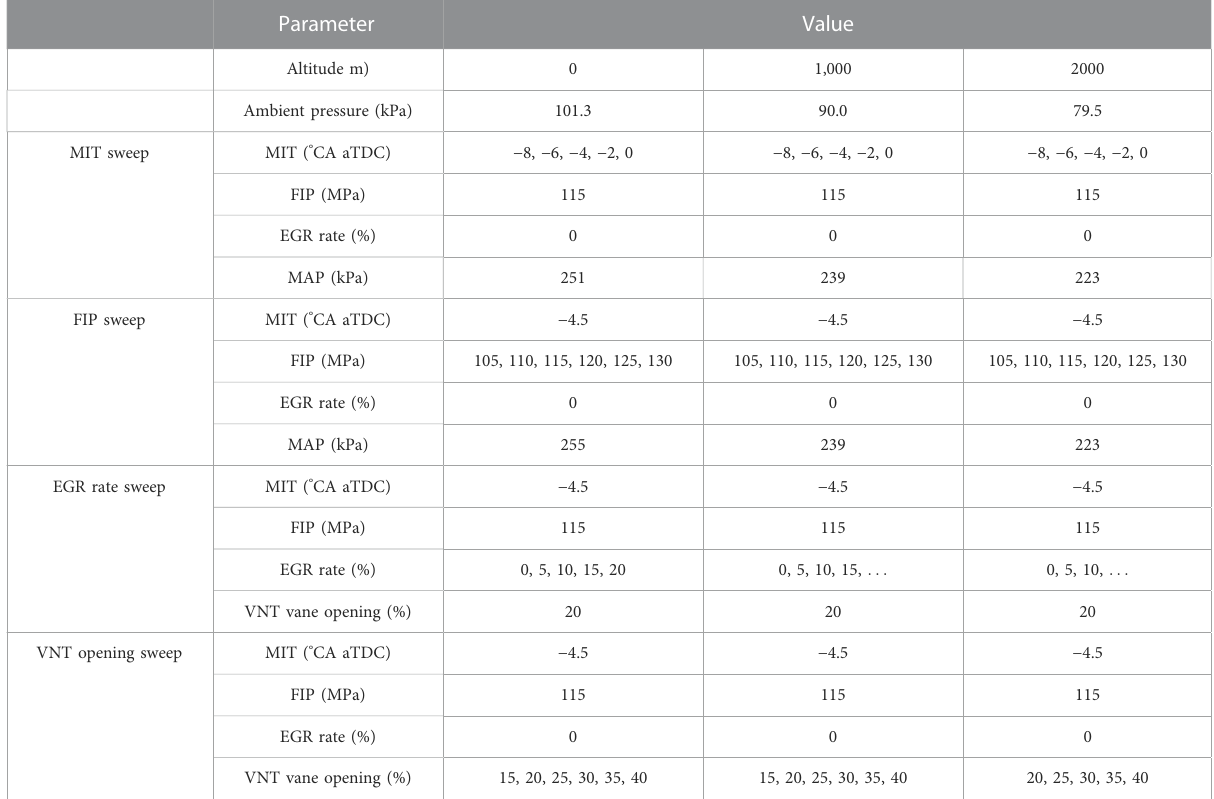
TABLE 3 The detail settings of selected control